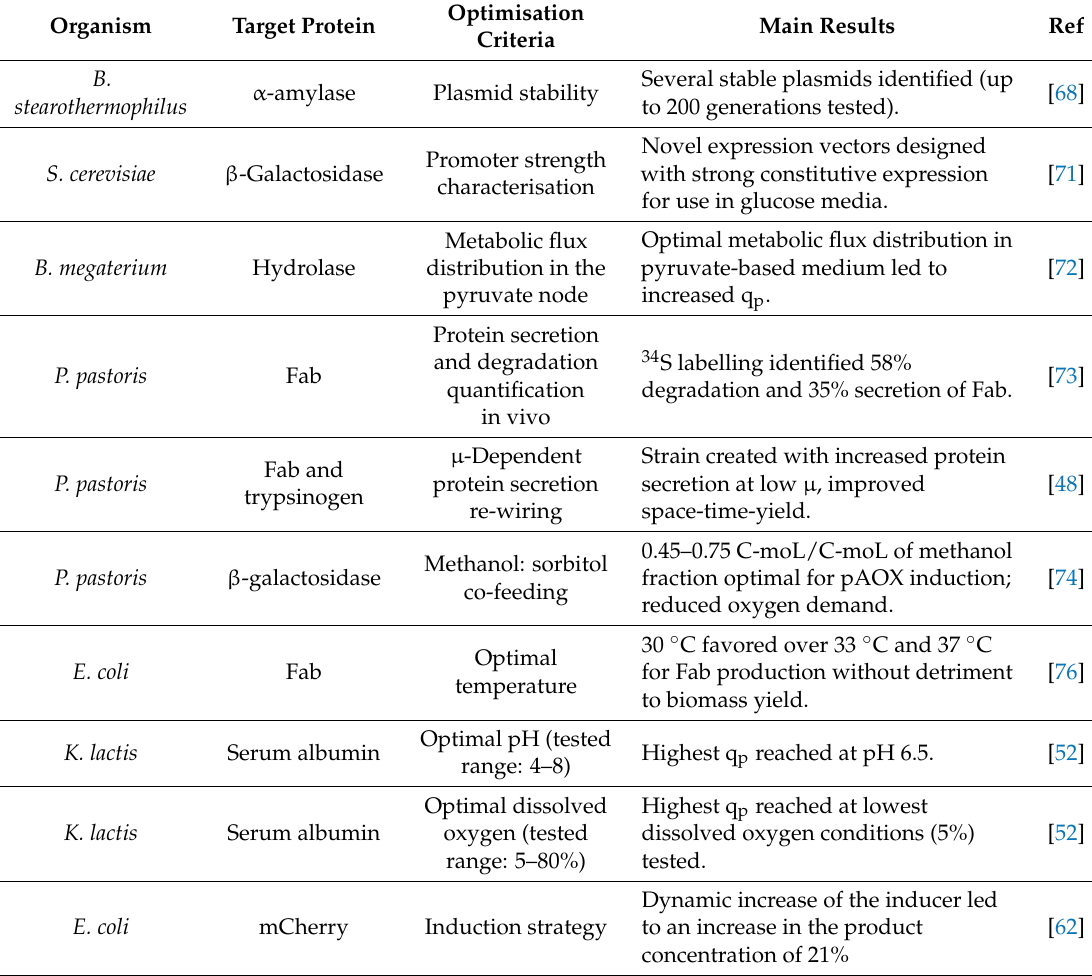
Table 2. Main results of selected recombinant processes optimized in continuous cultures.